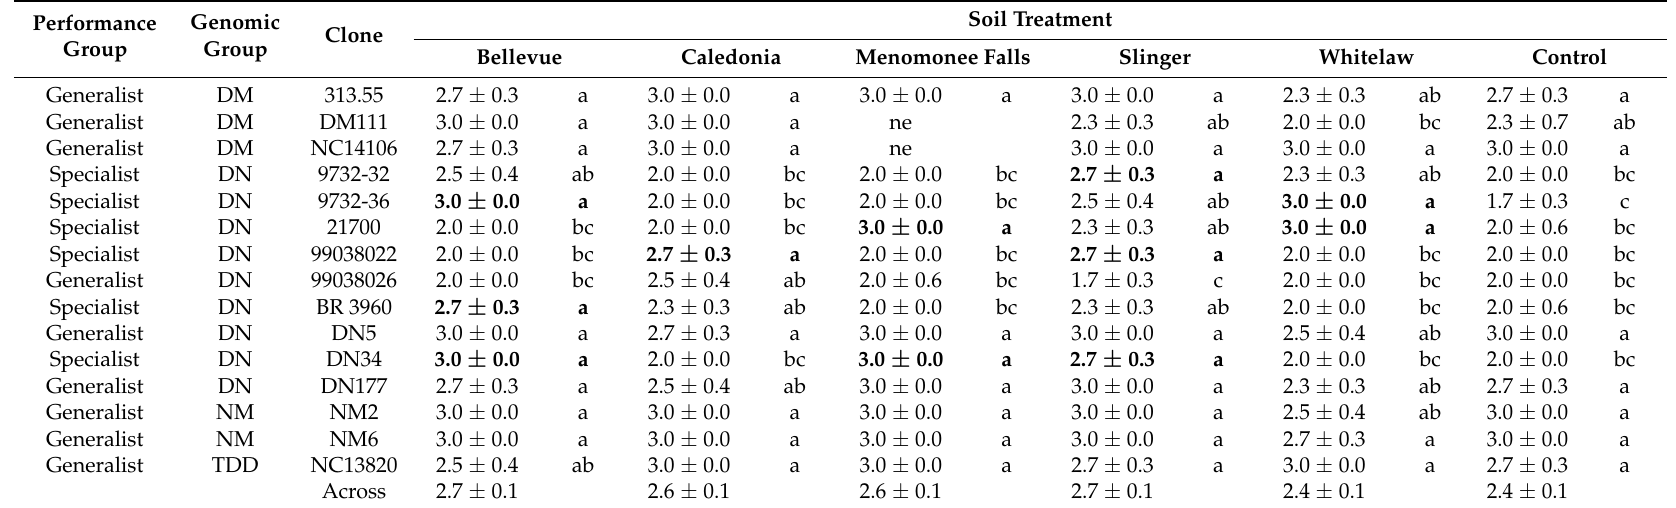
Table 4. Mean tree health scores ( n = 3) for each combination of soil treatment and hybrid poplar clone in a study assessing the relationships among root–shoot allocations, early growth, and health of hybrid poplar and willow clones when grown for 65 days in soils from five landfills in eastern Wisconsin,